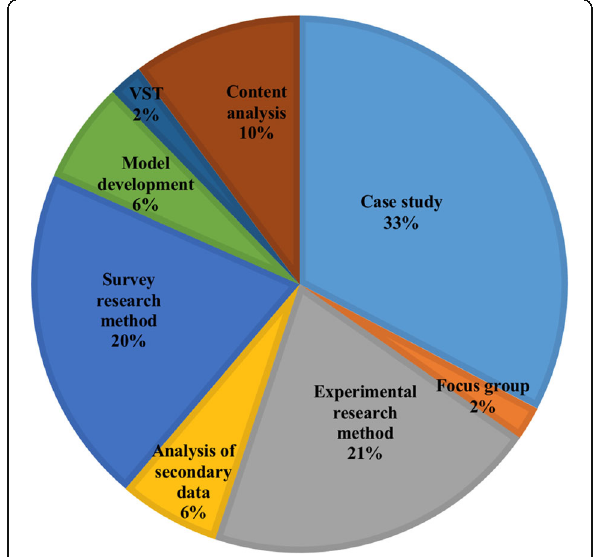
Fig. 1 Methodological techniques in greenwashing empirical research